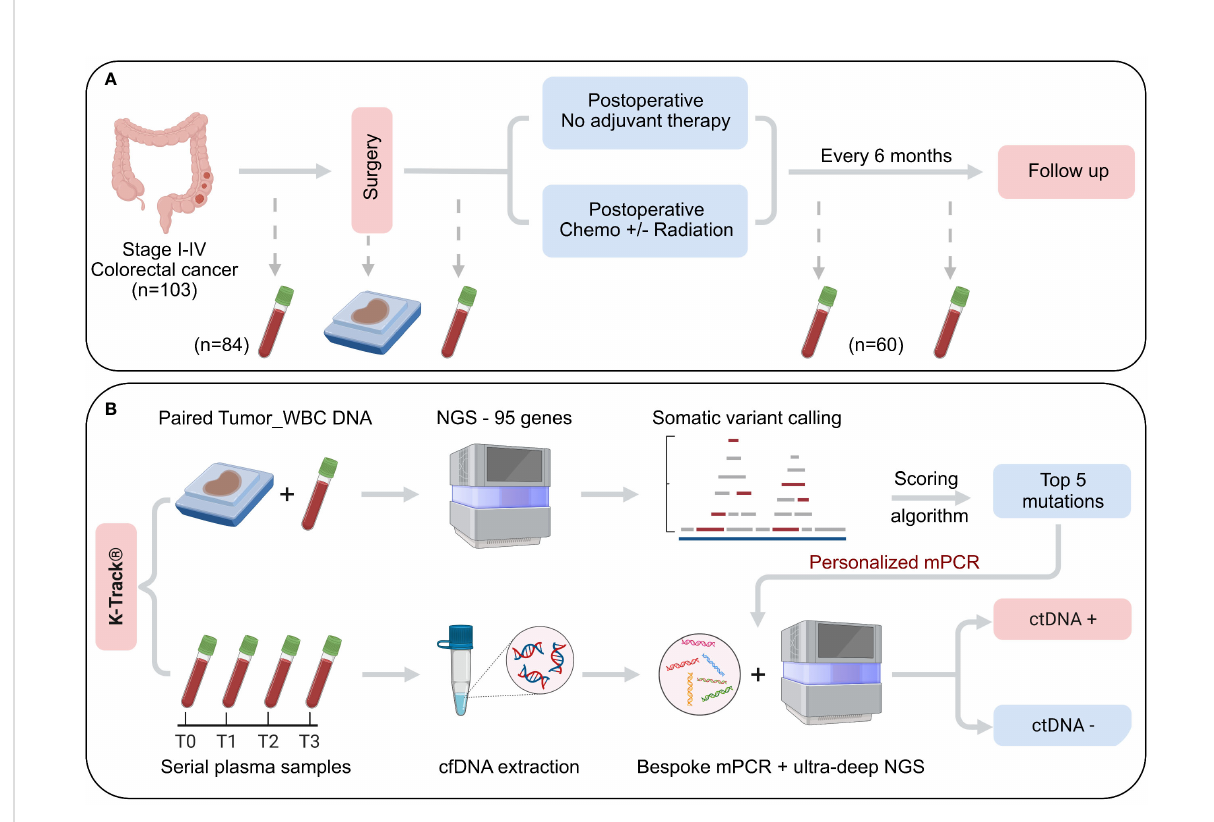
FIGURE 1 Schematic of study design and K-Track ® assay. (A) 103 patients with primary colorectal cancer stage I-IV, eligible for curative-intent surgery were enrolled. Serial plasma samples were collected before surgery and at scheduled visits after surgery. FFPE samples of surgically removed tumors were also collected. Clinical outcomes were recorded at each visit. (B) Genomic DNA of paired FFPE and WBC were sequenced to pro fi le all tumor-speci fi c somatic alterations in 95 cancer-associated genes. Top 5 mutations were selected by our K-Track ® scoring algorithm and then used to monitor ctDNA presence in plasma samples by a bespoke multiplex PCR assay and ultra-deep sequencing at an average of